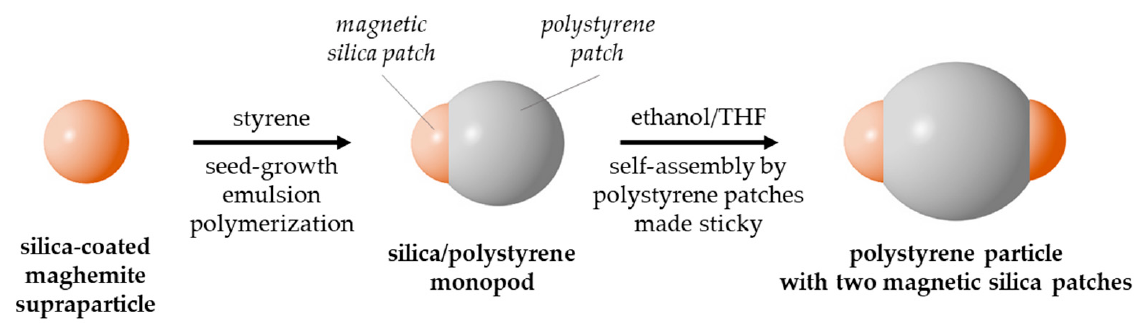
Figure 1. Scheme showing the two-step synthesis pathway to obtain polystyrene particles with several magnetic silica patches, exemplified here for two patches.